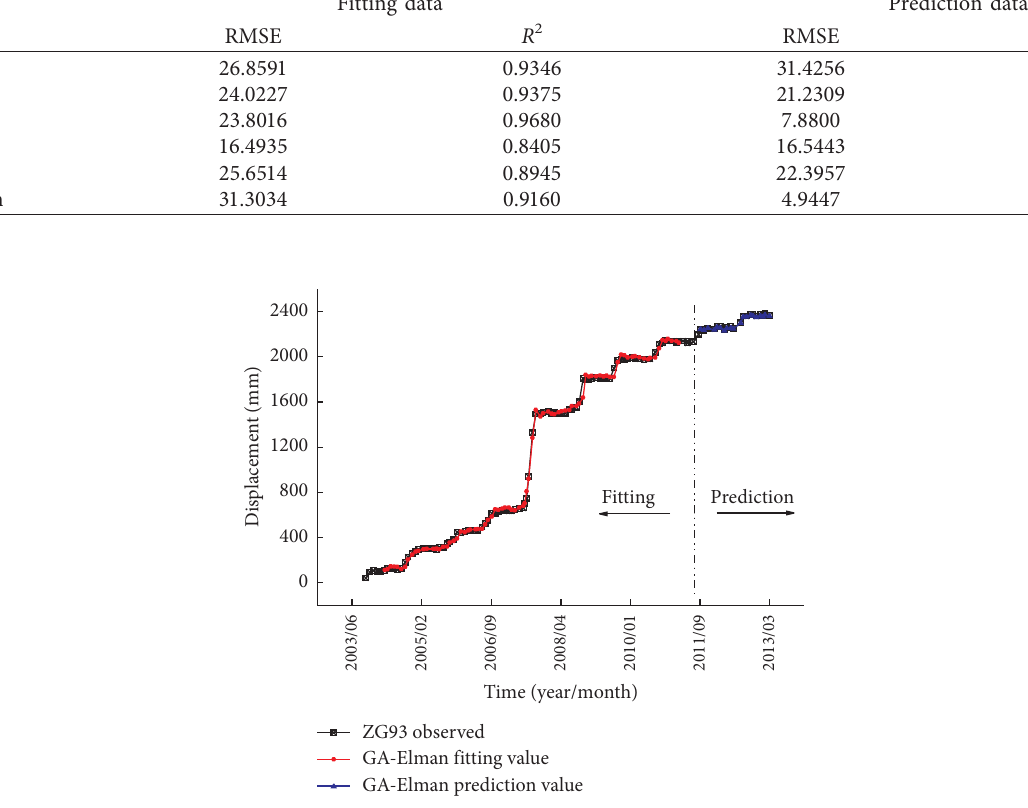
Figure 13: Predicted cumulative displacement through different models for point ZG93 in the Baishuihe landslide.